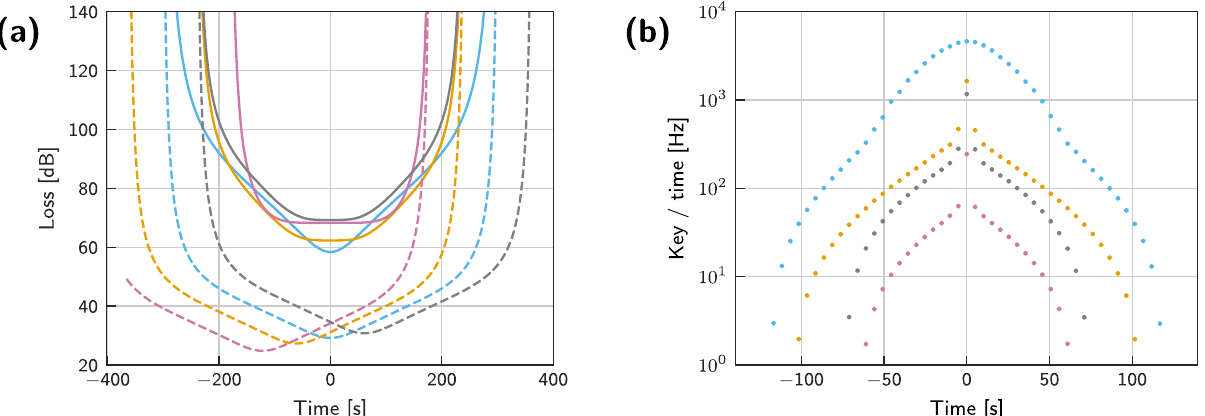
Fig. 5 Loss and key rates for a three-satellite network passing above ground stations d = 4400 km apart. The colors match the relative positions of the satellites in Fig. 3, such that when S C is exactly in the middle point between the ground stations S A will be at 0% (blue), 10% (orange), 20% (pink), or − 10% (gray) of the total ground distance d . a Combined atmospheric and diffraction loss between A and S C (dashed lines) and along the whole optical path (solid lines). b The obtainable asymptotic key rate for Scenario 1 at points along the orbit if satellites were static at these positions.